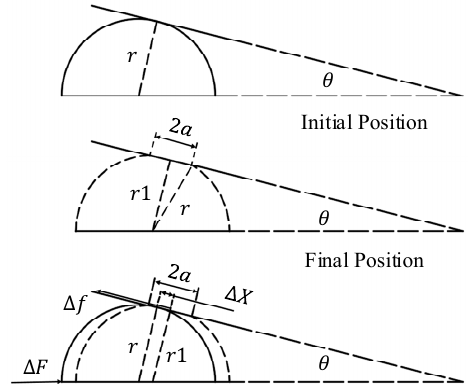
Figure 6. The force model of the ball valve.